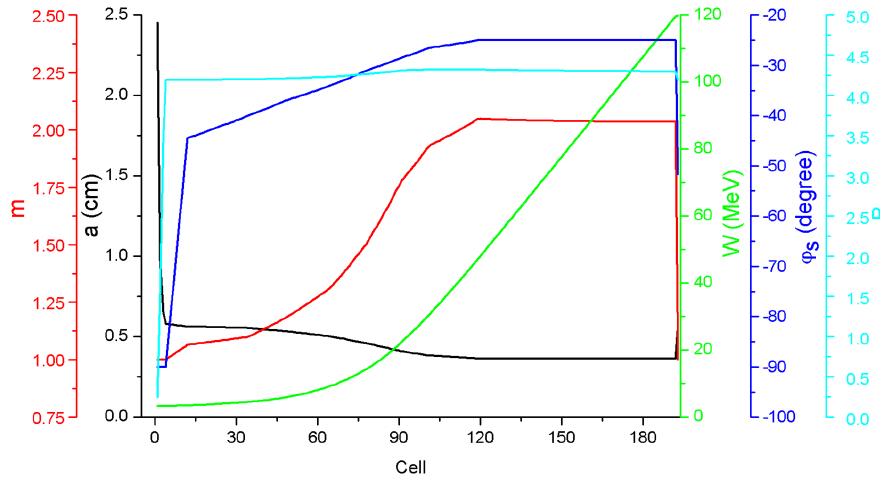
FIG. 22. Main parameters as a function of cell number for